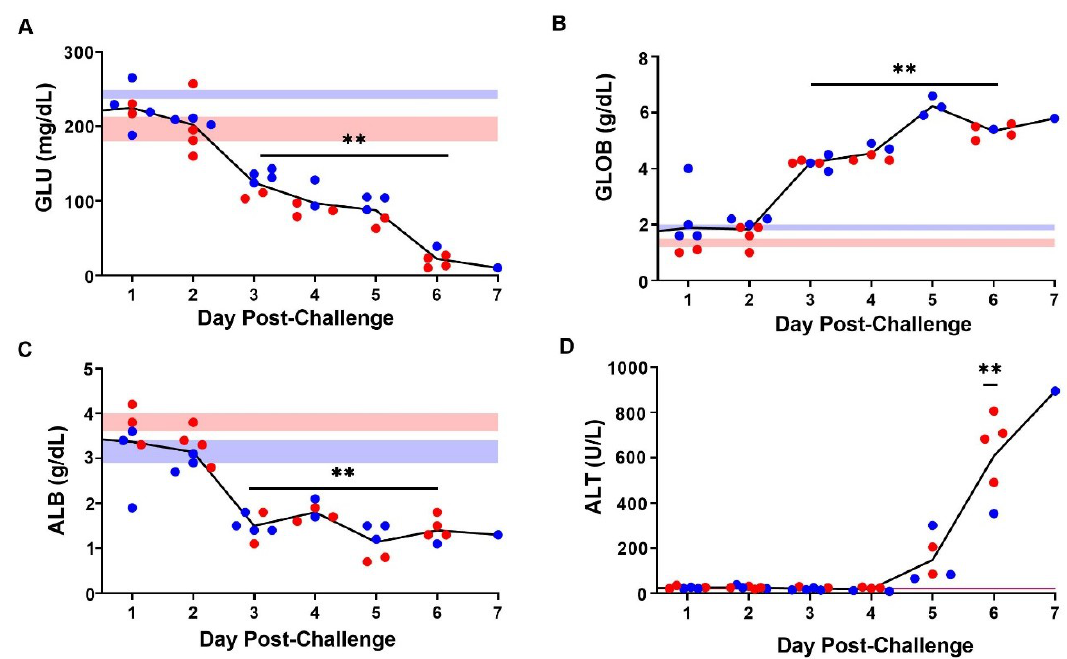
Figure 5. Changes in Serum Chemistry following SUDV Challenge. Black lines represent average glucose (GLU; A ), globulin (GLOB; B ), albumin (ALB; C ), and alanine aminotransferase (ALT; D ) levels. Symbols ( • and • ) represent individual values from a female or male mouse, respectively. Double asterisks (**) indicate significant differences ( p < 0.001) as compared to uninfected mice processed on day 0.